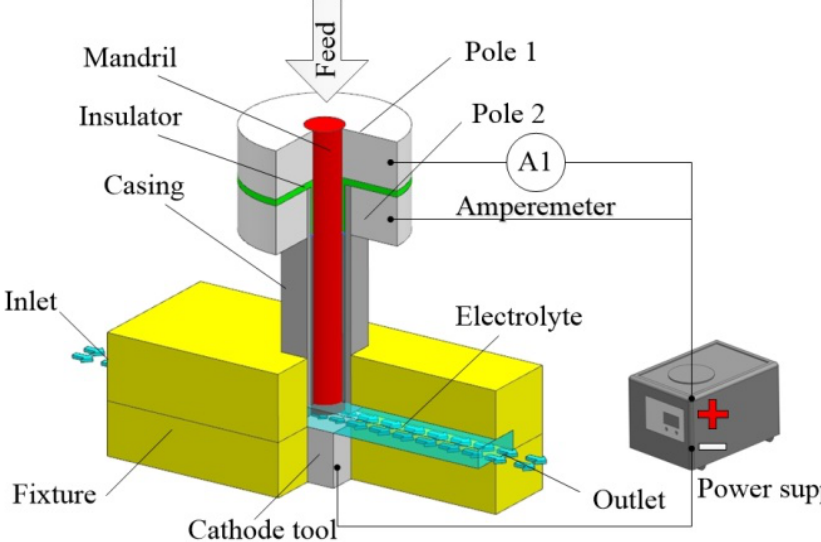
Figure 3. Schematic diagram of the measurement setup with casing-type anode.